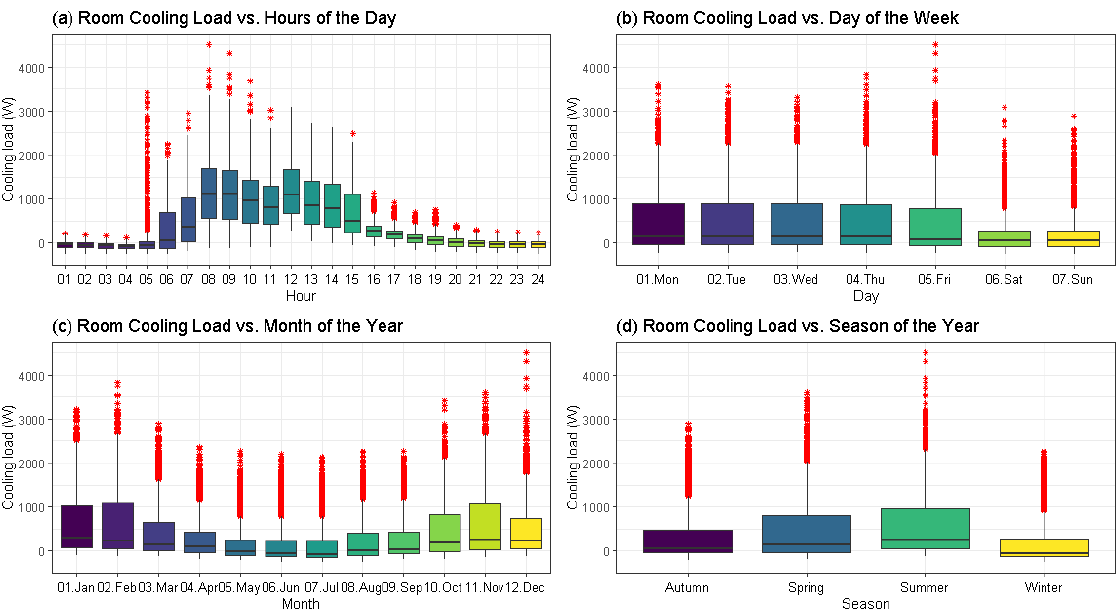
Figure 3. Room cooling load for different times of the year: ( a ) Room cooling load depicting variations in the hourly boxplots; ( b ) room cooling load depicting variations in the day boxplots; ( c ) room cooling load depicting variations in the monthly boxplots; ( d ) room cooling load depicting variations in the seasonal boxplots.